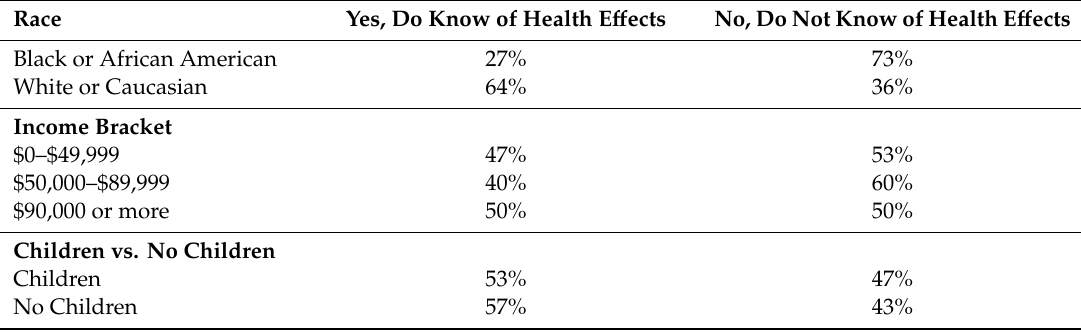
Table A8. Participants’ knowledge regarding potential health e ff ects of slag, lead, and / or arsenic in soil.